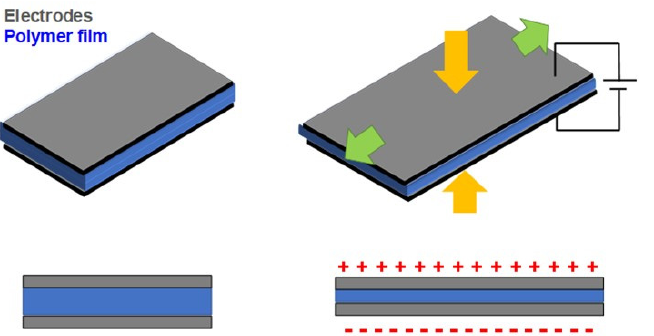
Figure 1. Schematic illustration of electromechanical actuation of a nonionic EAP dielectric